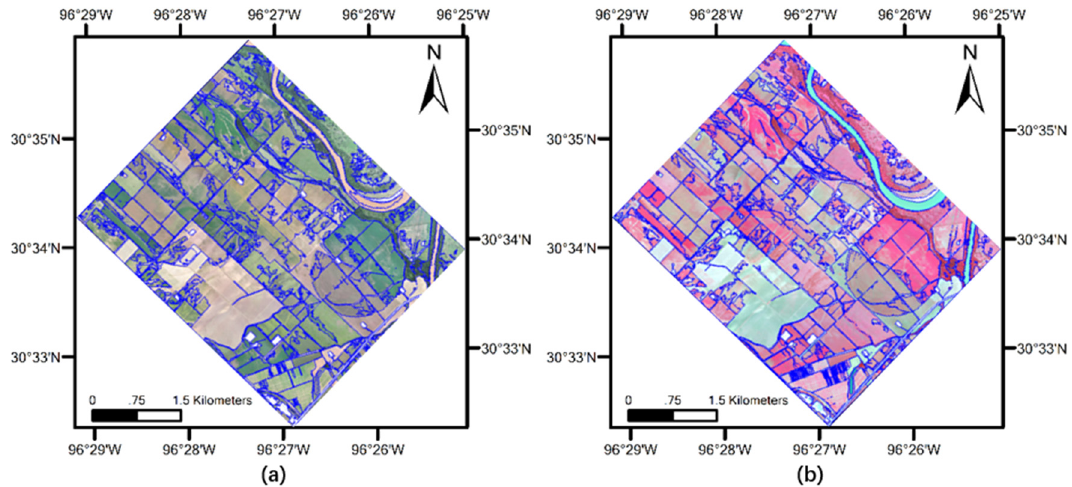
Figure 5. Image segmentation results: ( a ) three-band image segmentation with 970 image objects; and ( b ) four-band image segmentation with 950 image objects.